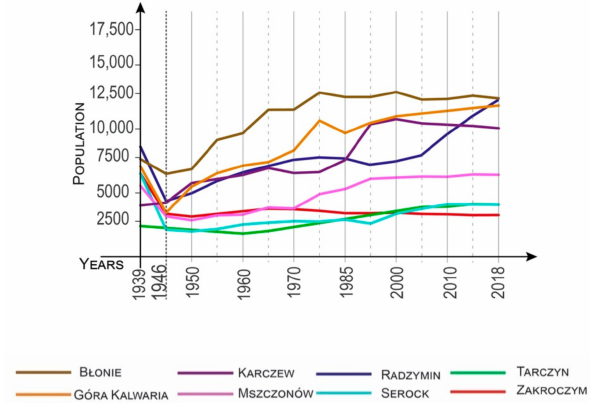
Figure 4. Changes in the population of selected cities in the years 1939–2018 (the lack of data for Tarczyn in 1978 results from its lack of city rights at that time). Source: own study based on the data of the Central Statistical O ffi ce of Poland, Local Data Bank and [82].